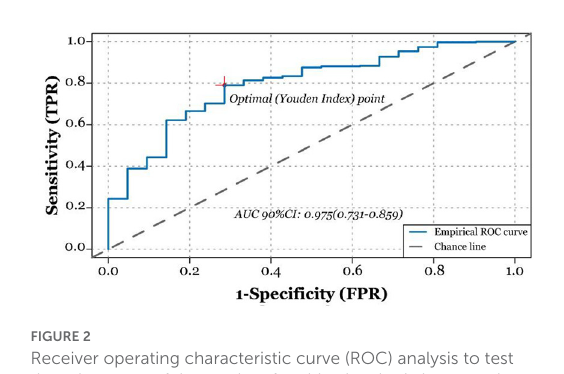
FIGURE2 Receiver operating characteristic curve (ROC) analysis to test the robustness of the results of multivariate logistic regression model analysis. Area under the curve is 0.795 (90% CI: 0.716, 0.875).